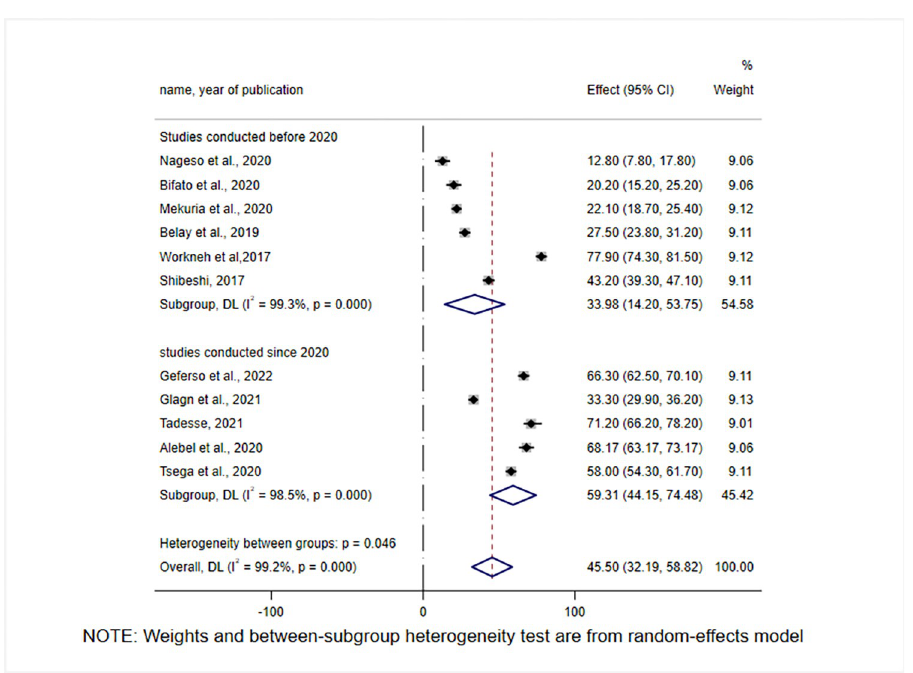
Fig 4. Subgroup analysis of CBHI enrolment in Ethiopia by study years, 2017–2022.